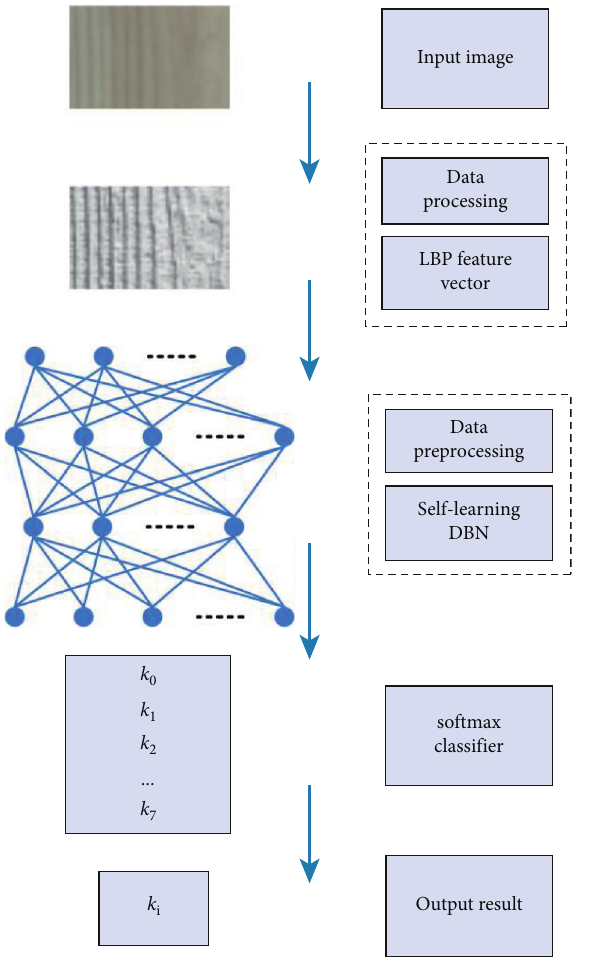
Figure 6: Wood pattern design process based on the theme search algorithm of multimedia resources.